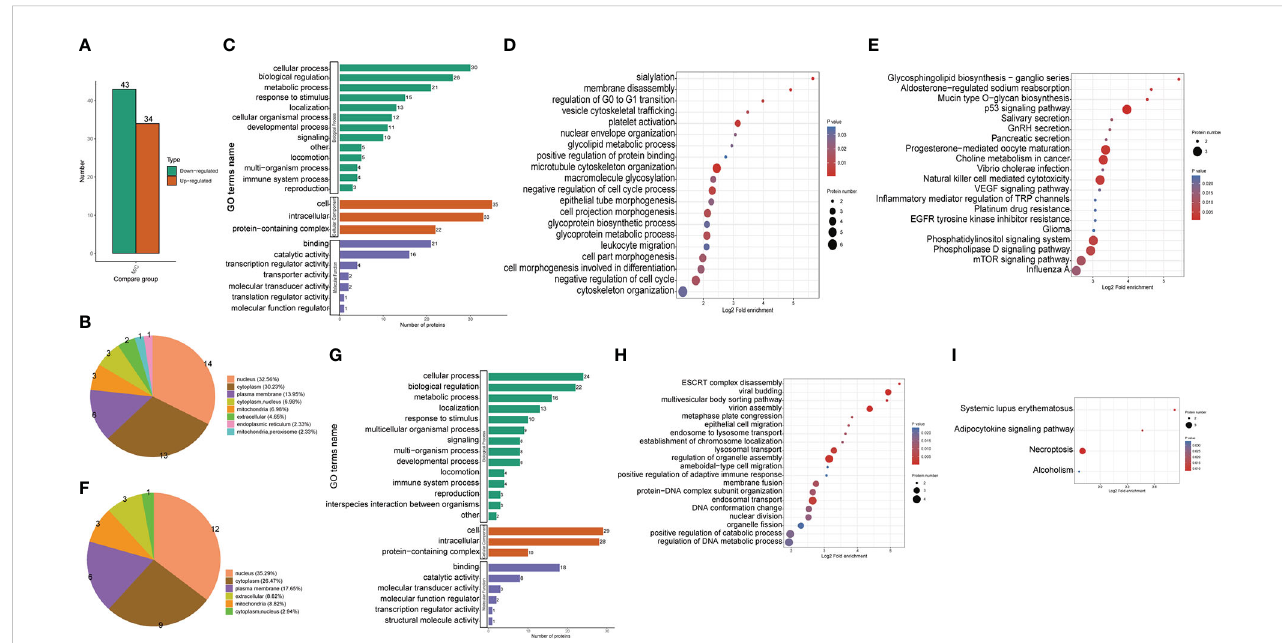
FIGURE 2 Proteomic identi fi cation and bioinformatics analysis of DEPs in THP1 cells in response to MRSA infection combined with vancomycin treatment vs. control cells. (A) The number of differentially expressed proteins compared the THP1 cells infected by MRSA for 3 hours then treated by vancomycin for 0.5 hours with control cells. Down-regulated proteins, (B) Pie chart of the percentage and number, (C) GO (Gene Ontology) pathway enrichment analysis, (D) Biological process (BP) category analysis, (E) KEGG pathway enrichment analysis. Up-regulated proteins, (F) Pie chart of the percentage and number, (G) GO pathway enrichment analysis, (H) Biological process (BP) category analysis, (I) KEGG pathway enrichment